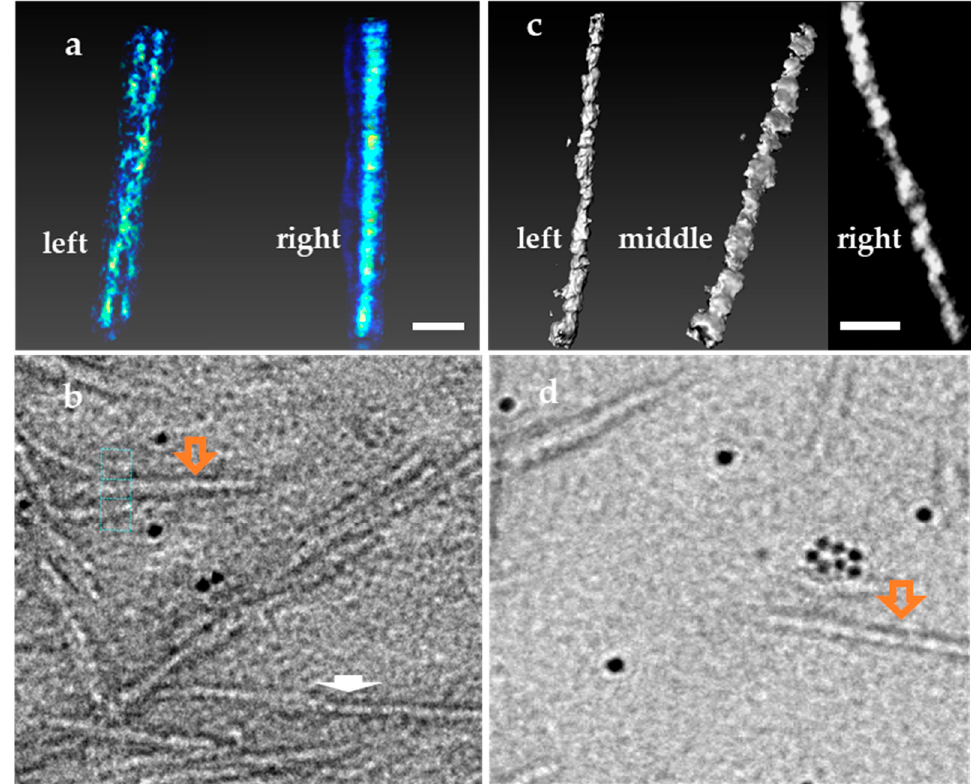
Figure 8. Geometrically twisted CNCs bundles and ribbon-liked CNCs coexists with rod-like CNCs (Sp3 specimen). Scale bars 10 nm. ( a ) Reconstructed 3D volume view of two helical CNCs twisted with an angle (left) and overlapped view (right); ( b ) 2D BF-TEM image of the twisted CNCs (marked as orange arrow) used for 3D reconstruction; ( c ) Reconstructed 3D isosurface of a ribbon-like CNC viewed at an angle with the narrowest width (left), widest width (middle) and the slice view (right); ( d ) BF-TEM image of the CNC used for 3D reconstruction (marked as orange arrow).